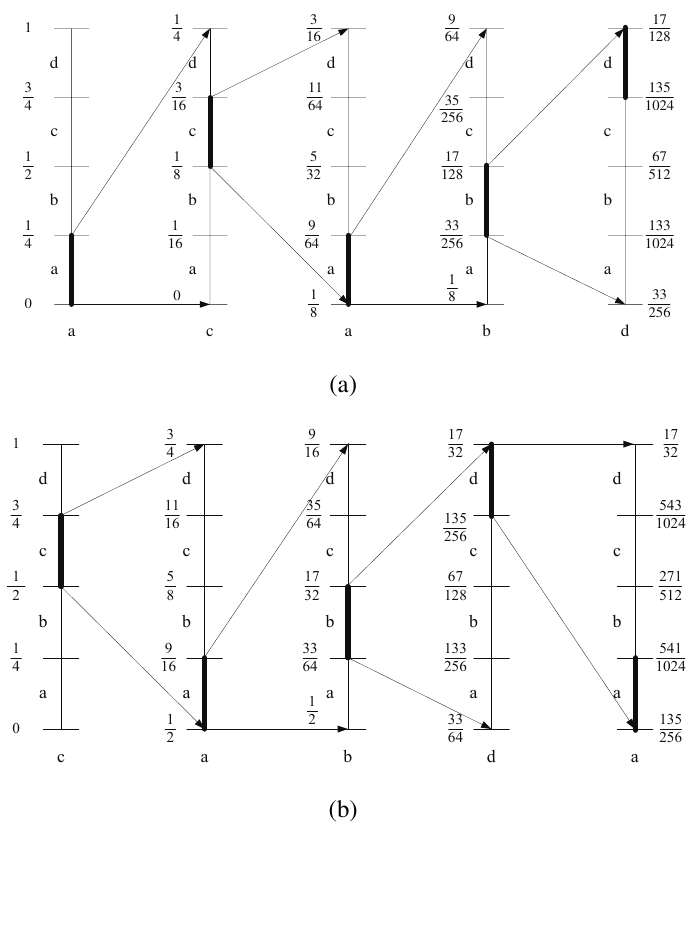
Code assignment procedure, using an example sequence. The vertical